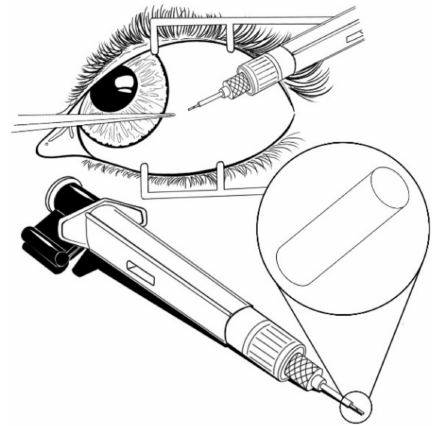
Figure 9. Yutiq (FA-loaded